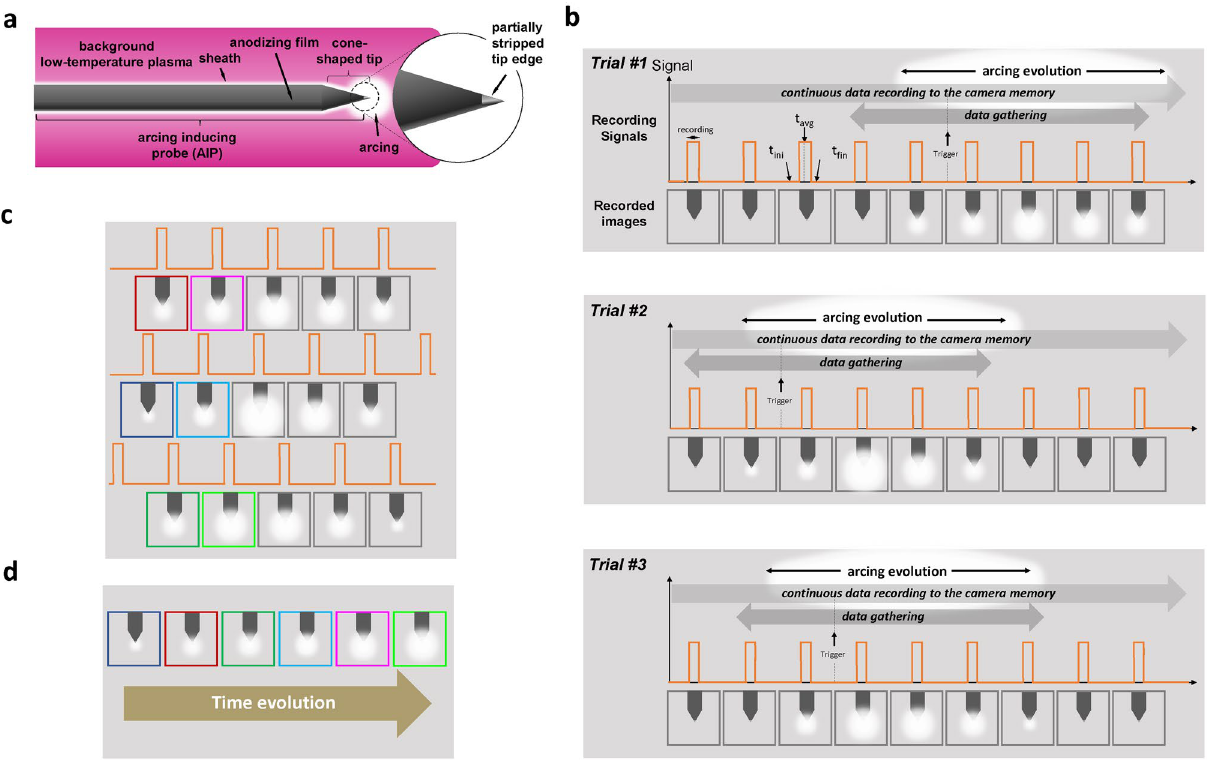
Figure 1. ( a ) Schematic diagram of the arcing inducing probe (AIP). ( b ) Schematic diagram of the multiple snapshot analysis method with several trials. The terms t ini , t fin , and t avg mean the beginning, termination, and average time of the ultra-high-speed camera recording, respectively. ( c ) Process of gathering arcing images and ( d ) sorting the images in time order.